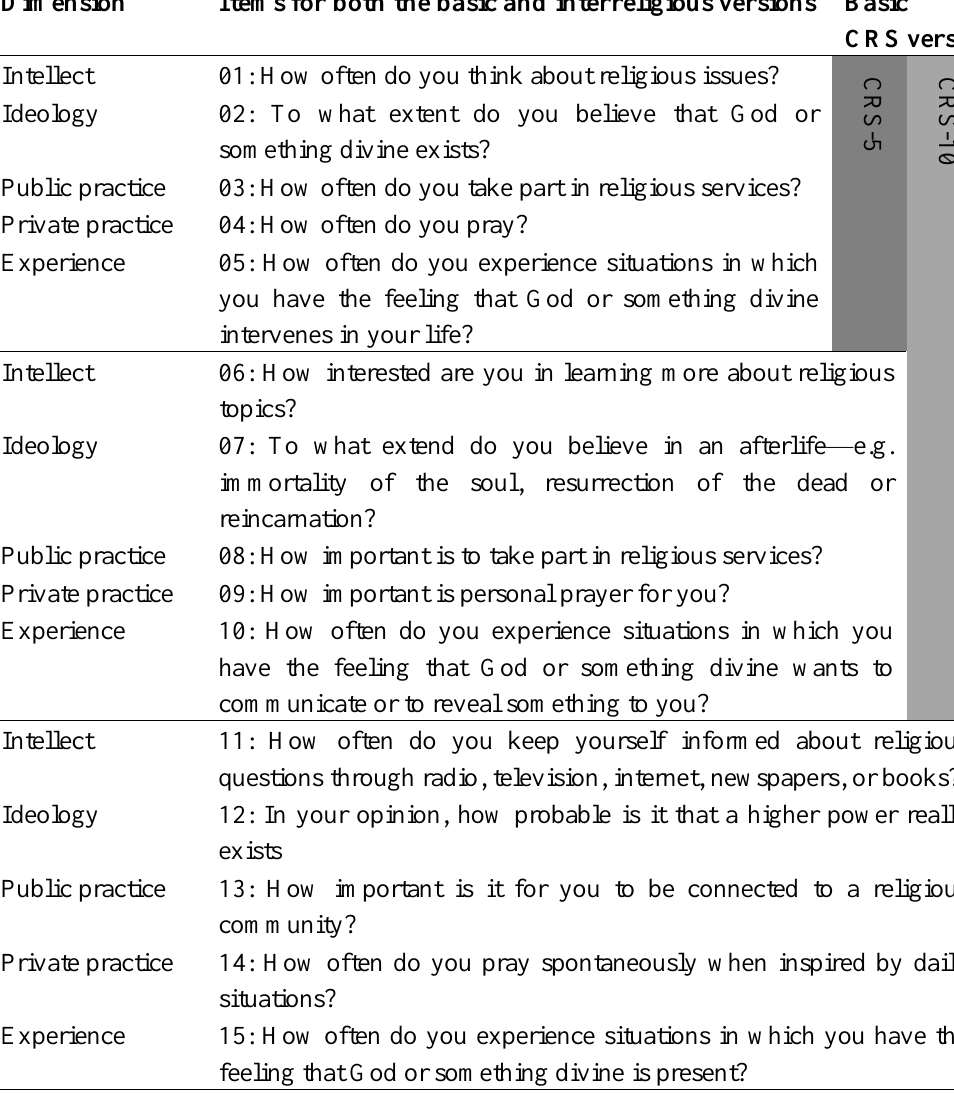
Interreligious CRSi